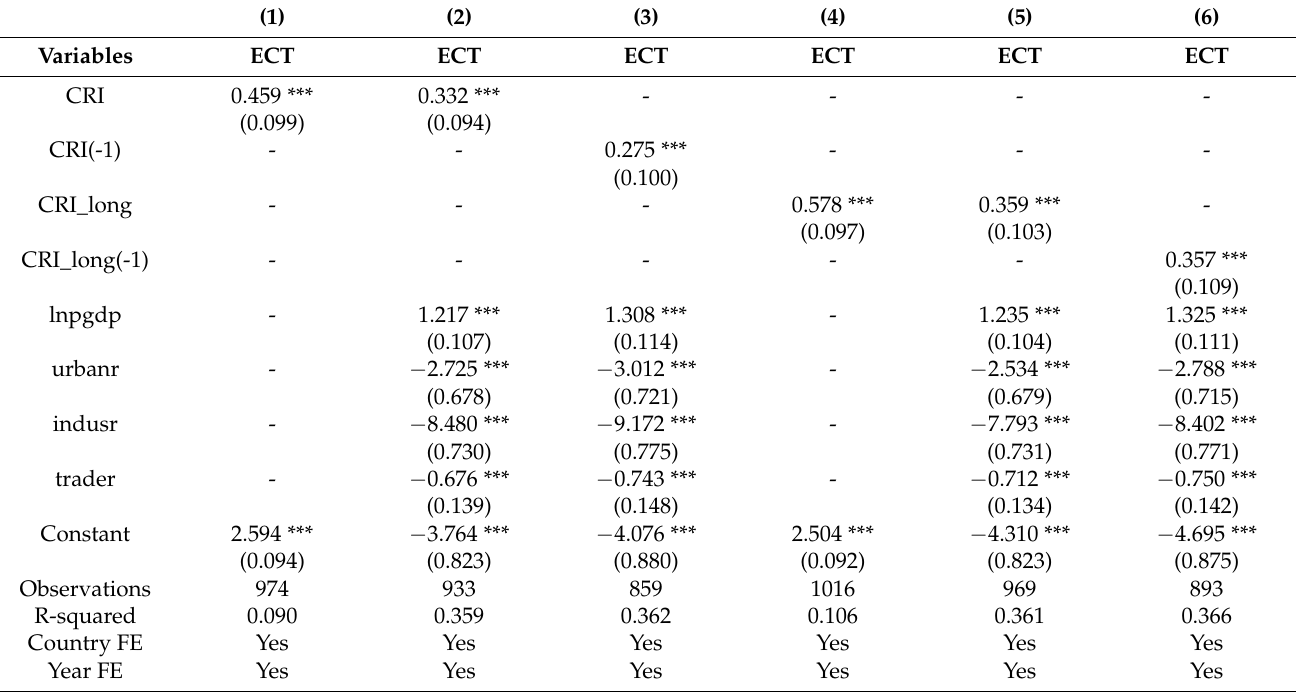
Table 4. Estimation results of the effect of climate risk on energy consumption